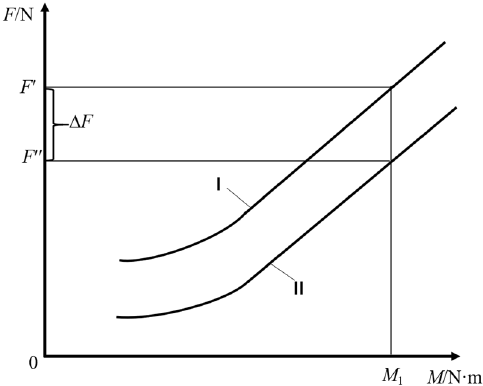
Figure 14. Torque method for tightening bolts [79].